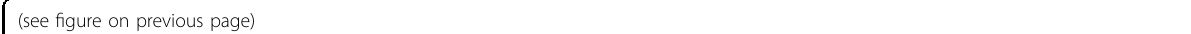
Fig. 1 Renal fi brosis, lymphangiogenesis, macrophage in fi ltration, and VEGF-C expression in UUO mice. A Kidney tissue from sham-operated (Sham) or unilateral ureteral obstruction (UUO) mice was tested by Masson staining (100×) and immunohistochemical analysis of α -SMA, F4/80, VEGF- C, and LYVE-1 (400×). There was a positive correlation between the number of LYVE-1 + vessels and the positive area (%) of α -SMA ( B ), F4/80 ( C ), and VEGF-C ( D ). E Protein expression of fi brosis markers ( α -SMA, collagen 1, and PDGFR- β ) and lymphangiogenesis markers (LYVE-1, Prox-1, and VEGF-C) in Sham and UUO mouse kidneys were measured by western blotting. F Quantitative analysis of the results in ( E ) was conducted to show the protein expression of fi brosis markers ( α -SMA, collagen 1, and PDGFR- β ) and lymphangiogenesis markers (LYVE-1, Prox-1, and VEGF-C) in Sham and UUO mouse kidneys. * p < 0.05, ** p < 0.01 versus the Sham group. G – L Relative mRNA expression of Collagen 1 ( G ), α -SMA ( H ), PDGFR- β ( I ), Prox-1 ( J ), VEGF-C ( K ), and LYVE-1 ( L ) in Sham and UUO mouse kidneys was measured by real-time PCR; * p < 0.05, ** p < 0.01 versus the Sham group. N = 6/